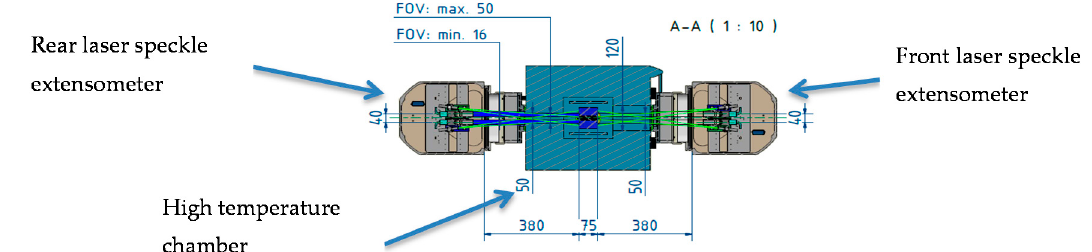
Figure 4. Furnace with two laser-speckle extensometers (courtesy of Messphysik).